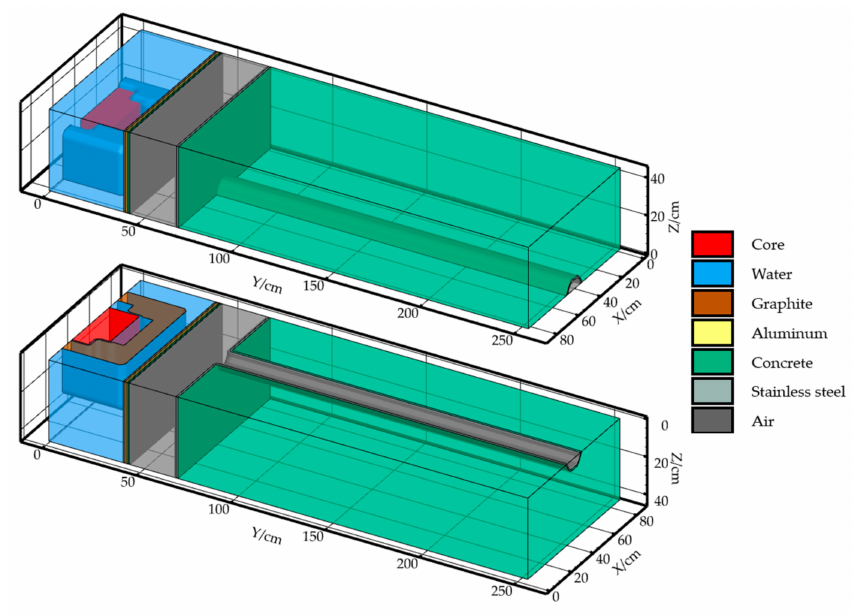
Figure 8. Geometry of the IRI-TUB benchmark